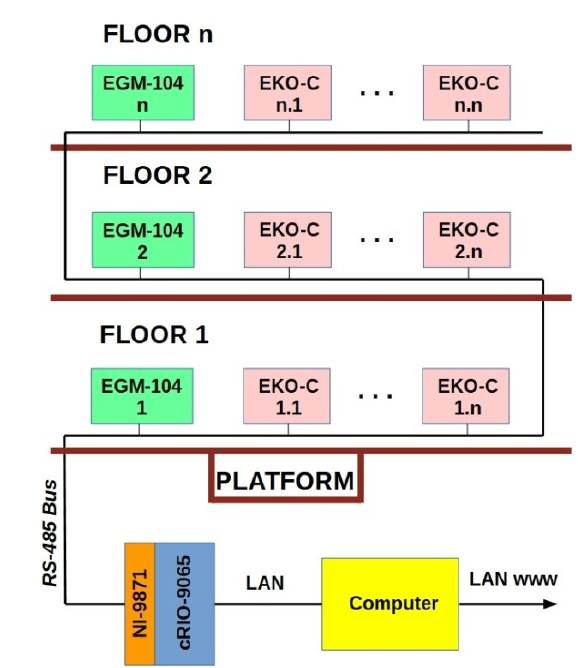
Table 1. Main information about detectors.